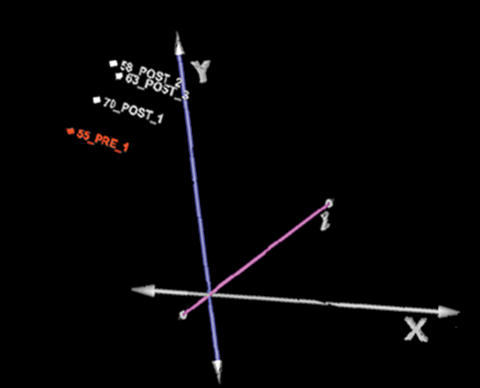
Principal Component Analysis. Principal Component Analysis, showing in three-dimensional space relationship between samples.